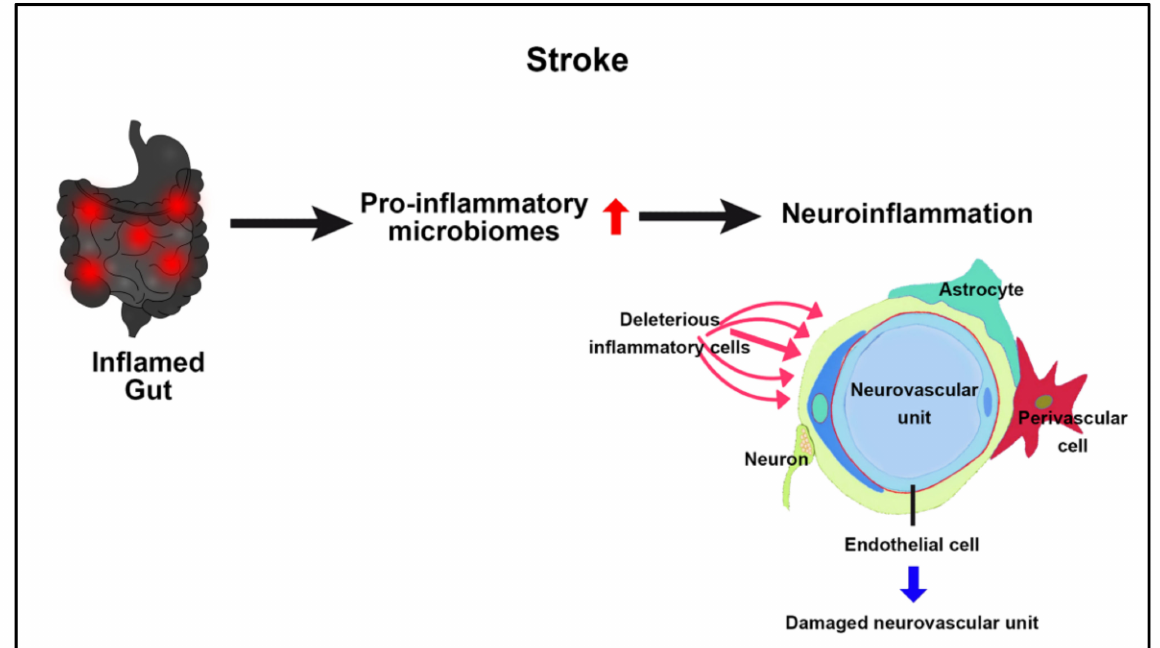
Figure 4. Stroke and GBA. Following the initial primary injury of ischemic injury (acute phase), the gut mounts an inflammatory response, resulting in the production of deleterious pro-inflammatory microbiomes, which, when uncontrolled over time (chronic phase), leads to detrimental inflammation that damages the neurovascular unit, thereby exacerbating stroke